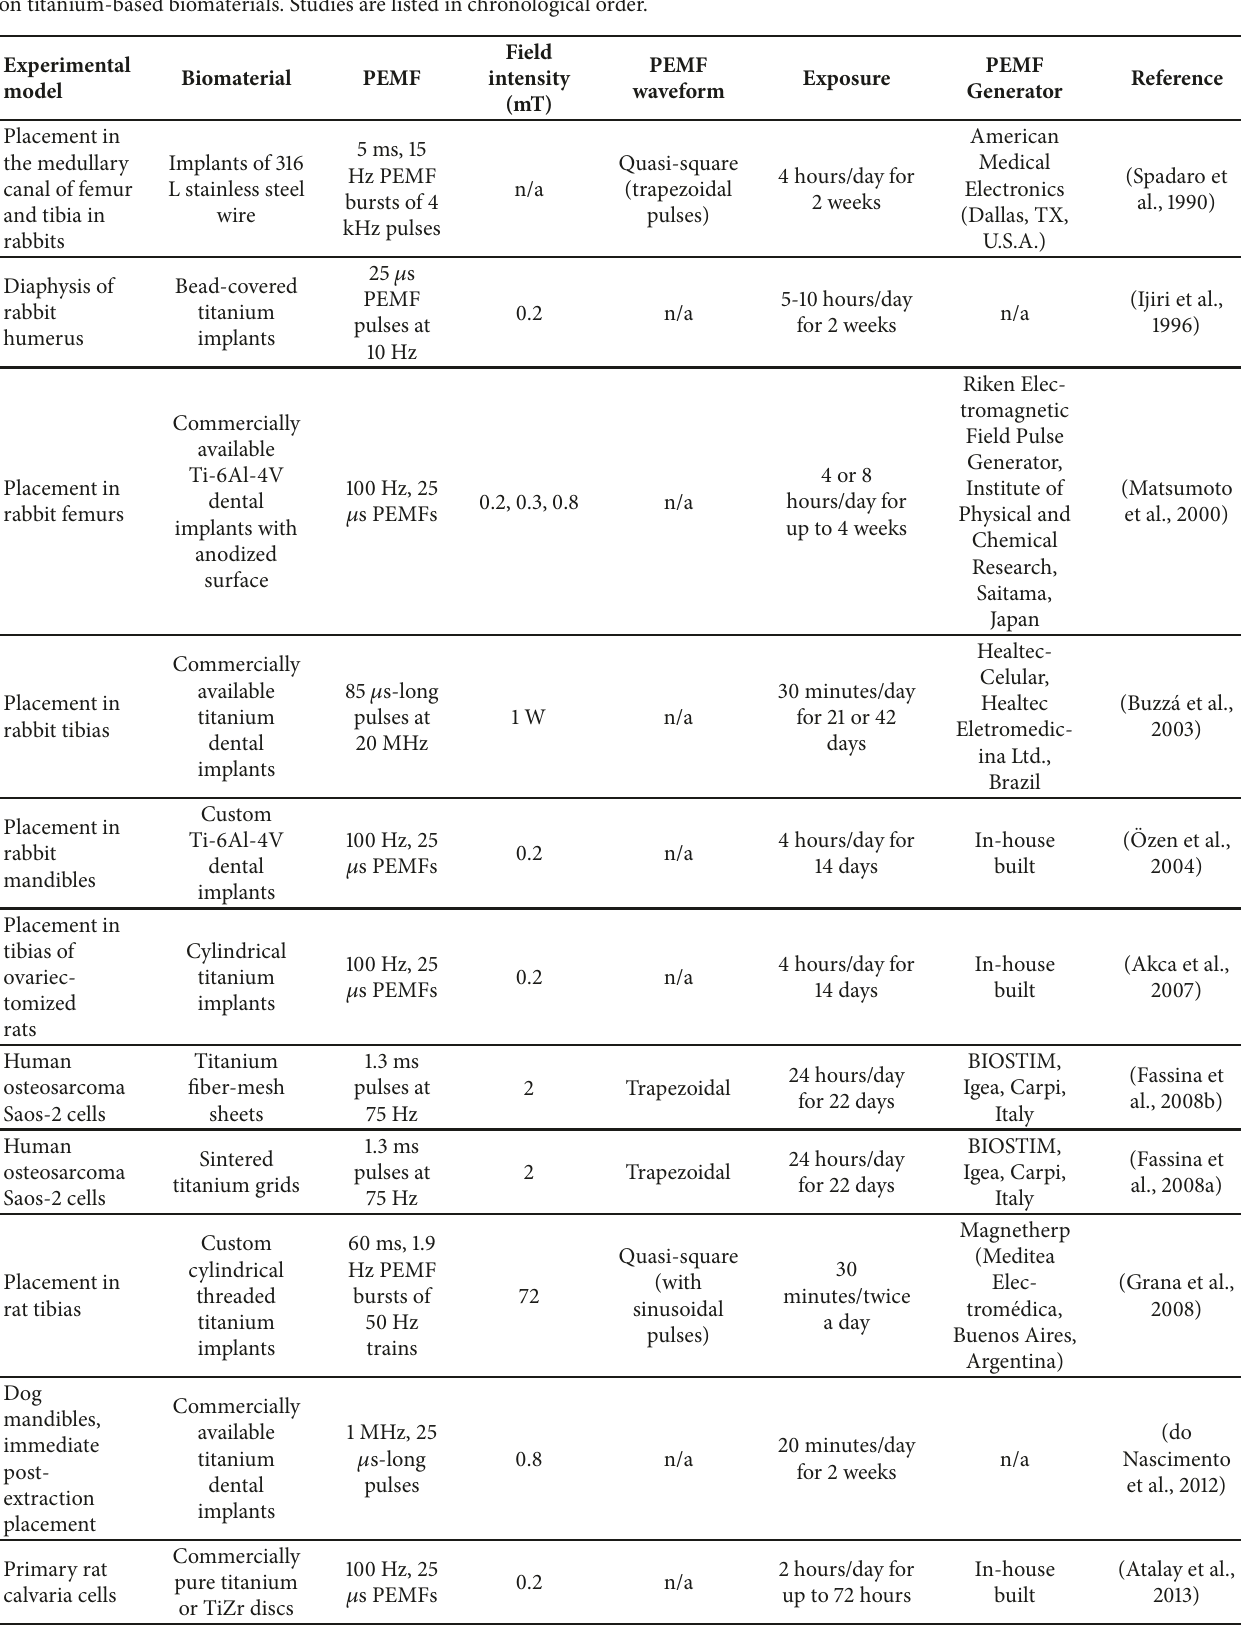
Table 2: The table summarizes the in vitro and in vivo studies on the effects of PEMF stimulation on osteoblastic primary cells and cell lines on titanium-based biomaterials. Studies are listed in chronological